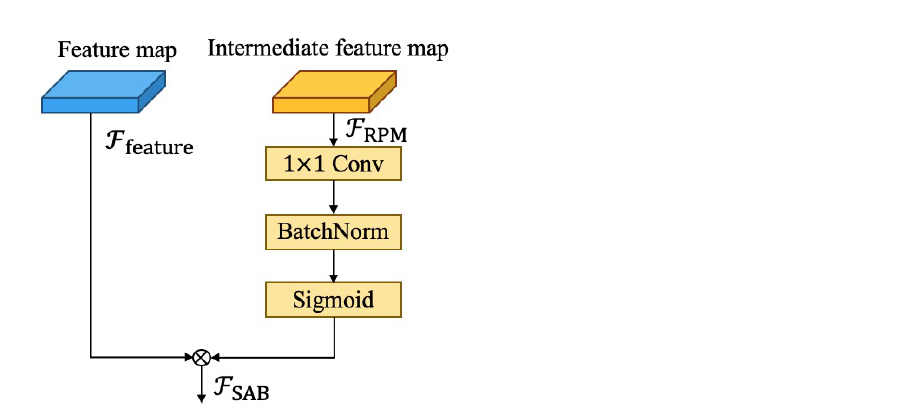
Figure 7. Spatial attention block.